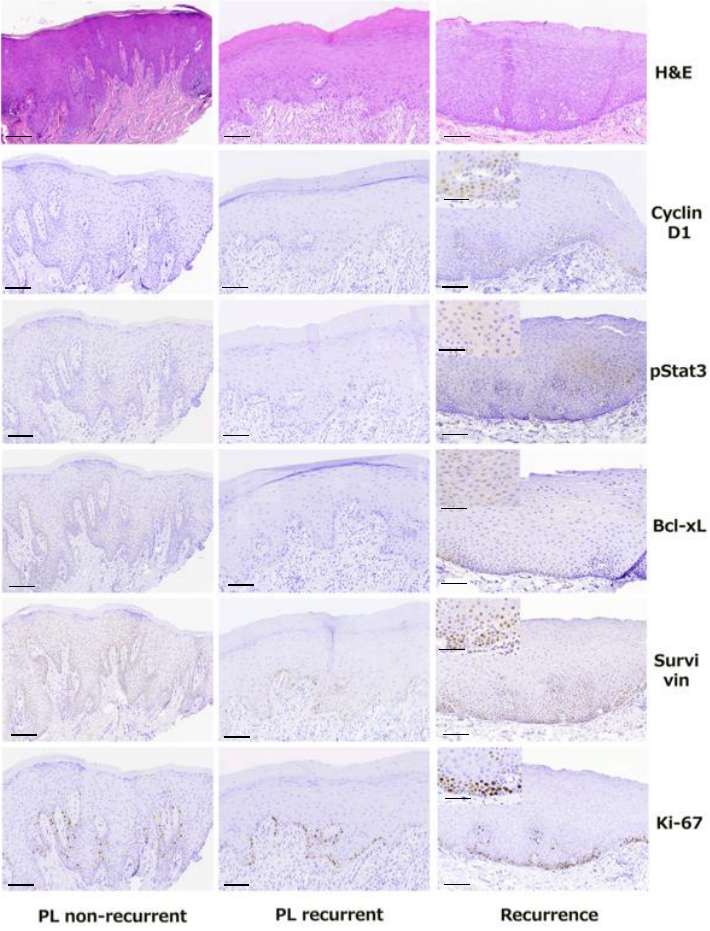
Figure 3. Representative photomicrographs of hematoxylin and eosin (H&E) and immunohistochemical stains of all studied molecules (cyclin D1, pSTAT3, Bcl-xL, survivin and Ki-67) in a non-recurrent primary oral leukoplakia lesion (PL)–1st column, in a recurrent PL–2nd column and in its corresponding recurrence–3rd column (magnification 100×, scale bar 100 μm; for inserts magnification 200×, scale bar 50 μm).